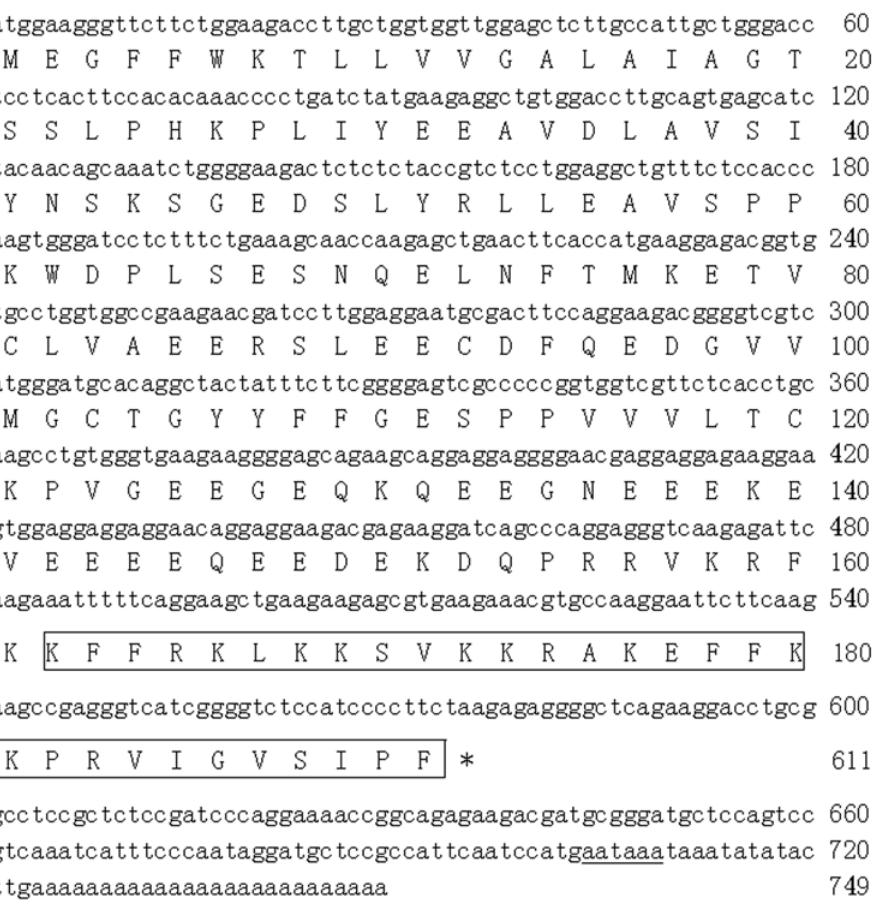
Figure 1. The cDNA sequence encoding cathelicidin-BF and the predicted precursor amino acid sequence. The amino sequence of purified cathelicidin-BF is boxed . The stop codon is indicated by a star (*). The potential polyadentlation signal (AATAAA) is underlined .